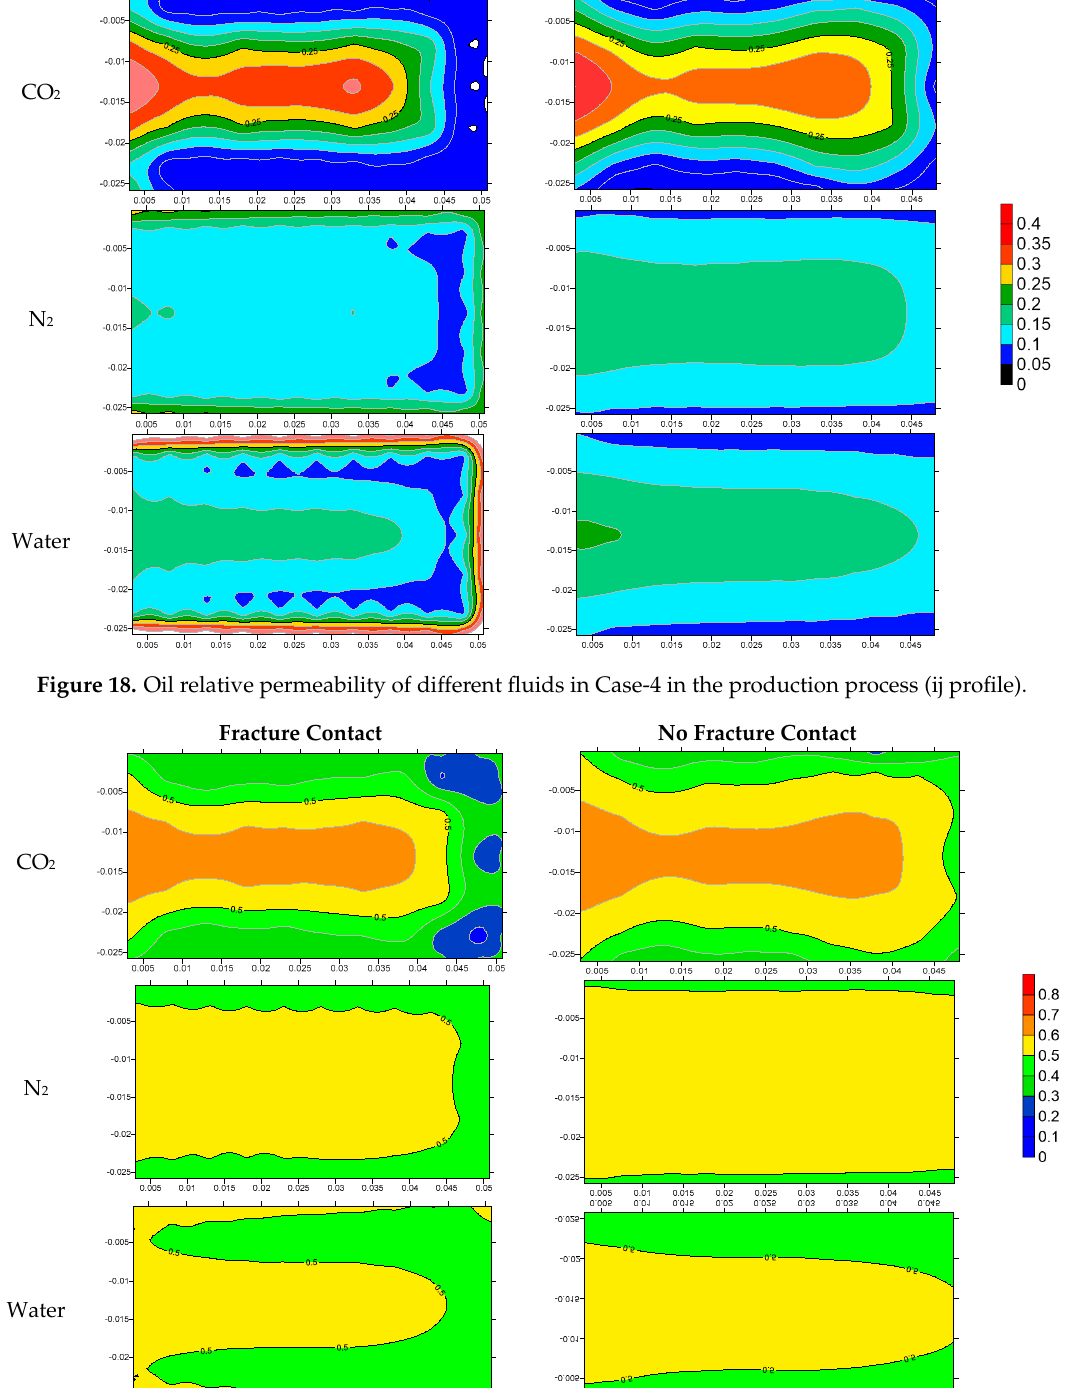
Figure 19. Oil saturation of different fluids in Case-4 in production process (ij profile).